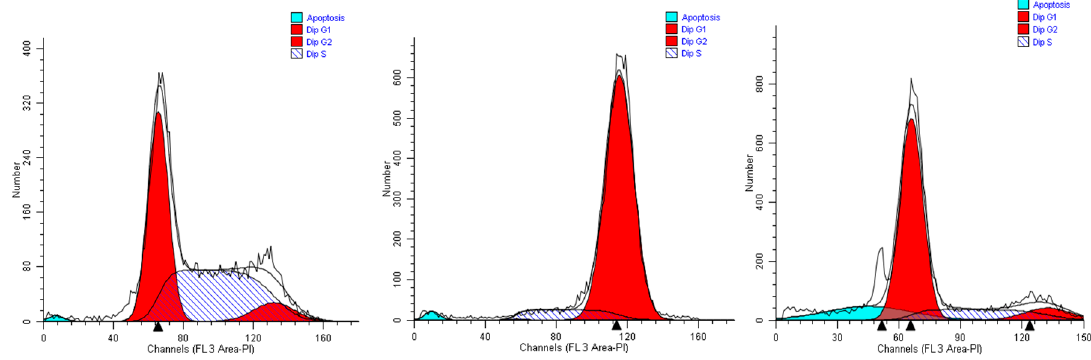
Figure 4. Representative cell cycle profiles of untreated A549 cells (controls, left ), and cells incubated in media containing 0.15% ( v / v ) of extracts #46 ( middle ) and #57 ( right ).